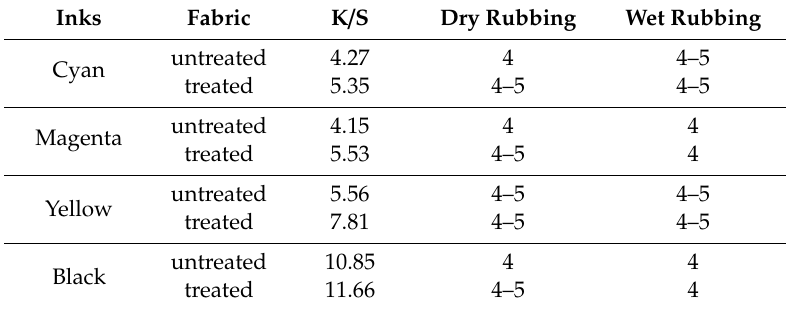
Table 4. K / S value and color fastness and properties of inkjet printed on untreated and treated fabric. Inks Fabric K / S Dry Rubbing Wet Rubbing untreated 4.27 4 4–5 Cyan treated 5.35 4–5 4–5 untreated 4.15 4 4 Magenta treated 5.53 4–5 4 untreated 5.56 4–5 4–5 Yellow treated 7.81 4–5 4–5 untreated 10.85 4 4 Black treated 11.66 4–5